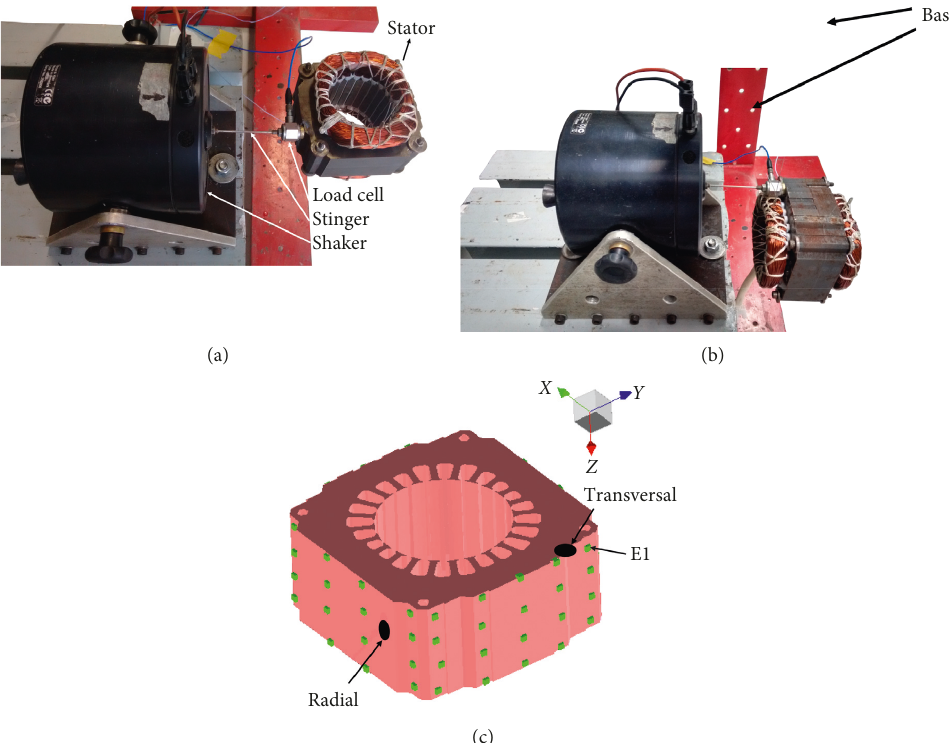
F IGURE 4: Experimental setup for modal analysis of the stator: (a) excitation in the radial direction ( y direction); (b) excitation in the transversal direction ( z direction); (c) experimental mesh with 50 points.